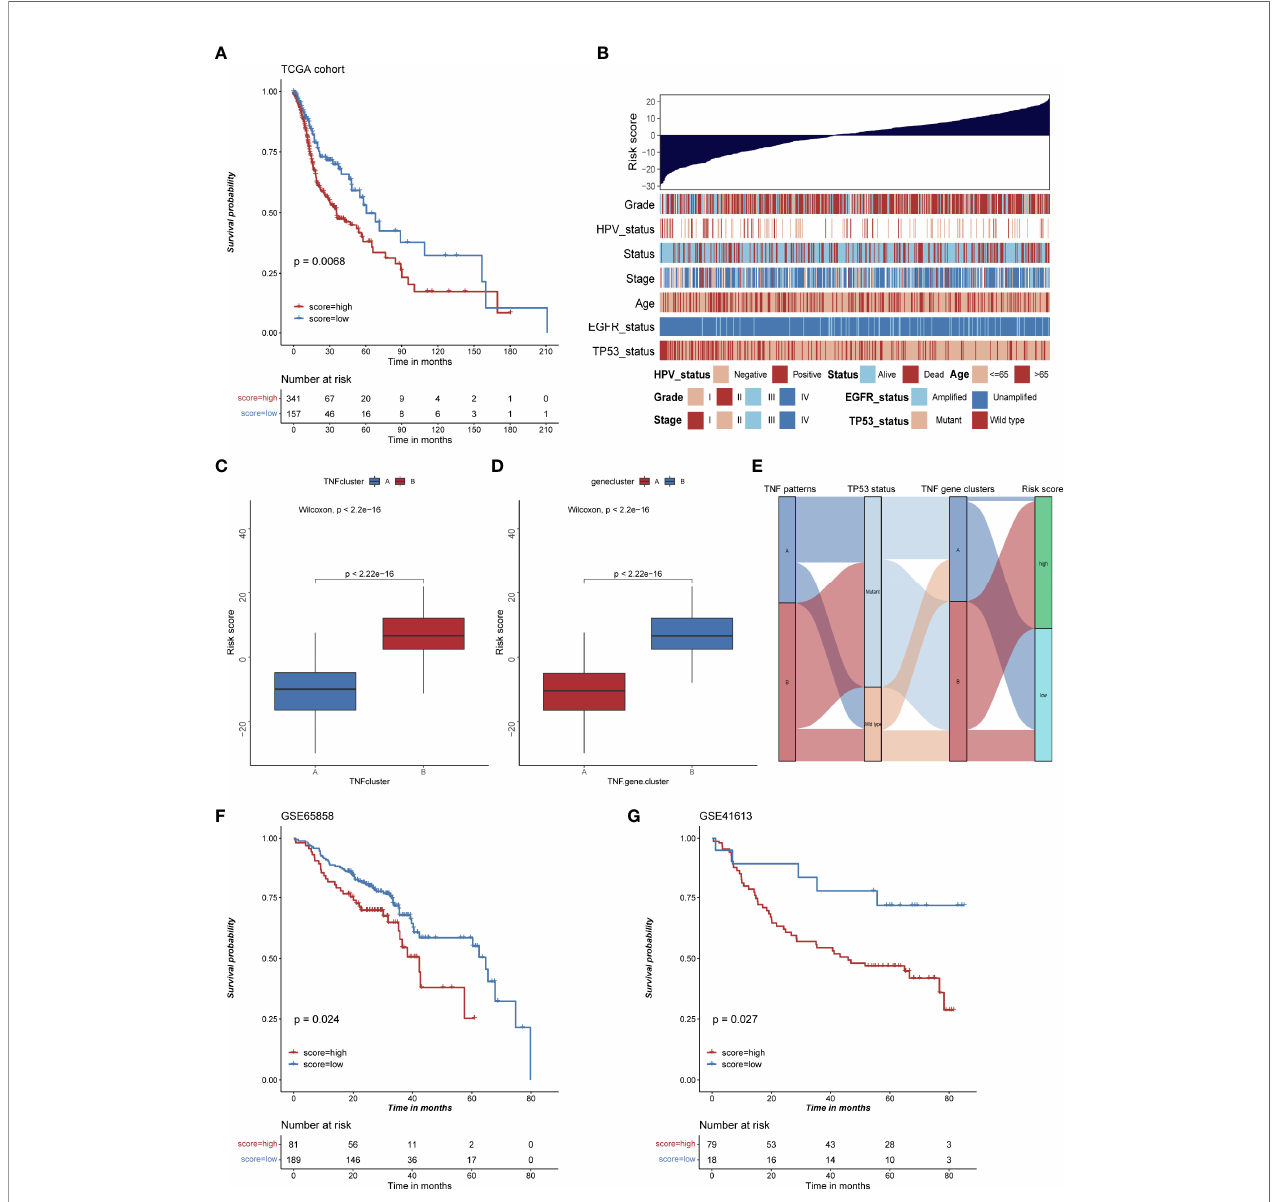
FIGURE 6 | The construction of risk score and its clinical signi fi cances. (A) Kaplan-Meier survival analysis of high and low risk score group in TCGA HNSCC cohort. (B) Bar chart depicting the relationship of risk score and various clinical characteristics in the TCGA HNSCC cohort. HPV status, TP53 status, stage, pathological grade, age, and survival status were used as sample annotations. (C) Boxplot of risk score in TNF cluster A and B (D) Boxplot of risk score in TNF gene cluster A and B (E) Alluvial diagram depicting the relationship of TNF cluster, TNF gene cluster, TP53 status and risk score group, TNF cluster/gene cluster A was associated with low frequency of TP53 mutation and low risk score. (F) Kaplan-Meier survival analysis of high and low risk score group in GSE65858 cohort. (G) Kaplan-Meier survival analysis of high and low risk score group in GSE41613